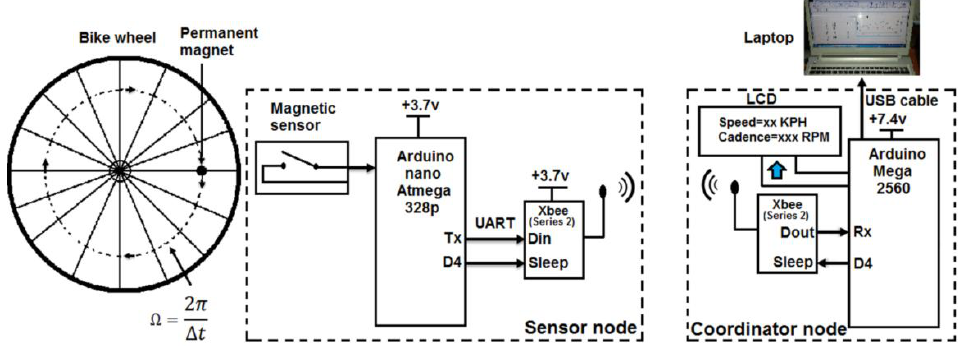
Figure 1. Block diagram of the whole framework of bike speed and cadence measurement.